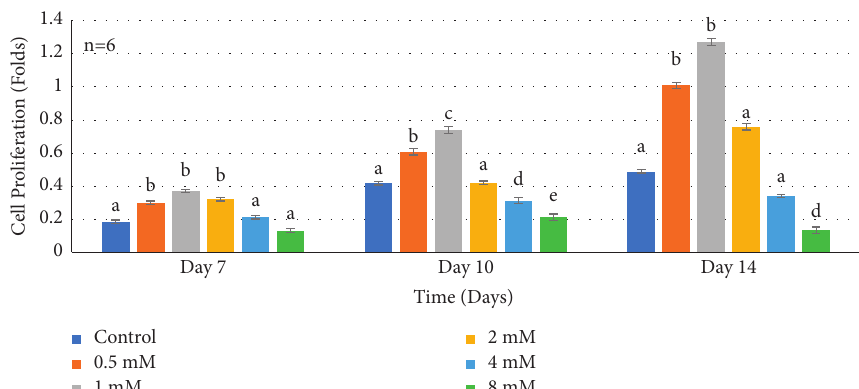
Figure 3: Histogram showing proliferation rates of normal human dental pulp cells in media with supplemental Mg 2+ concentrations. Note: normal human dental pulp cells were cultured with media containing supplemental Mg 2+ concentrations 0.5mM, 1 mM, 2mM, 4 mM, and 8mM and 0mM as the control group after addition of preinductive dentinogenic media for time periods of 7, 10, and 14 days. The data are presented as means of six replicates with error bars indicating the standard deviation. Groups labeled with different letters differ statistically as compared to the control group and other study groups ( P < 0 . 0001).